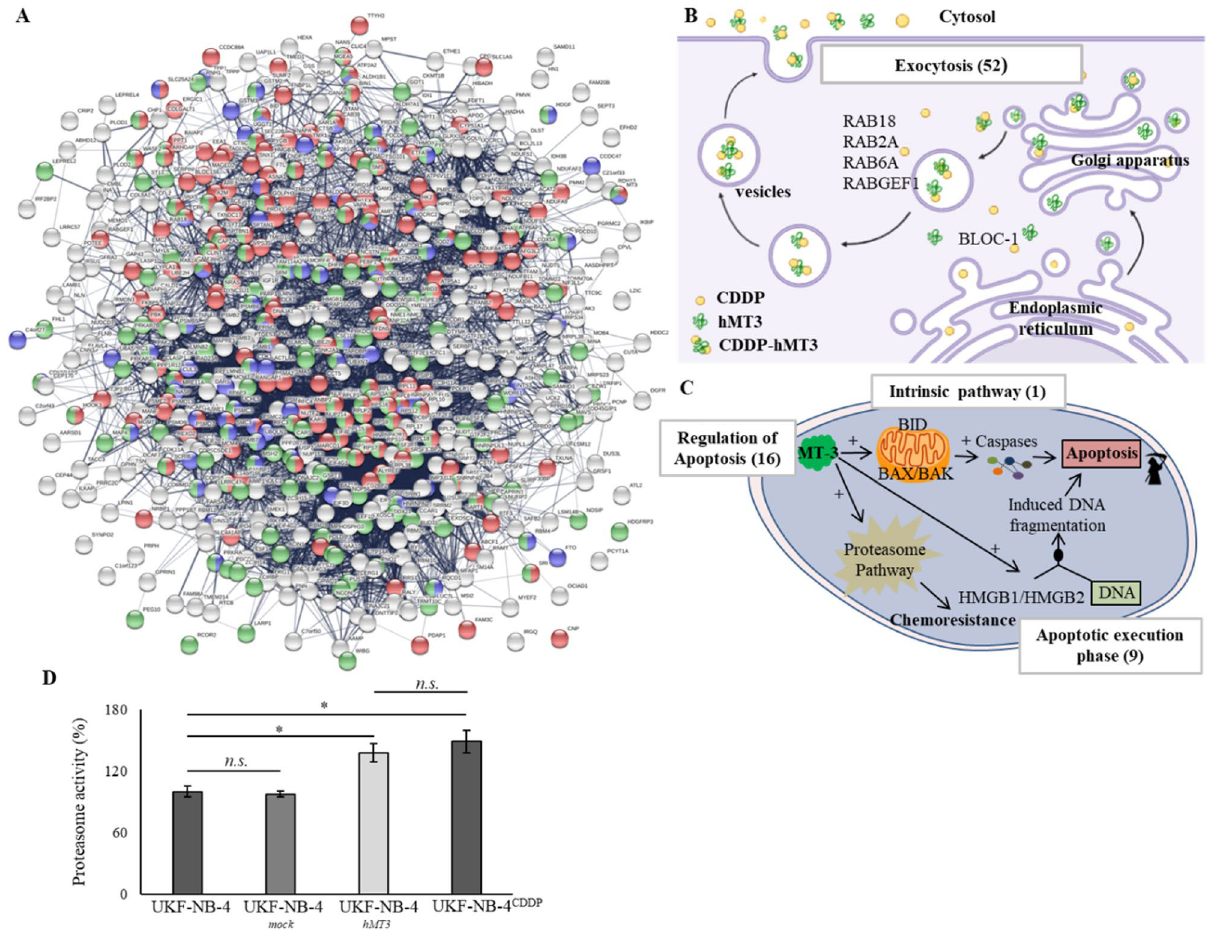
Figure 5. ( A ) STRING interactome network showing the proteins, which were found exclusively expressed and up-regulated in UKF-NB-4 hMT3 cells compared to mock cell line. These are involved in transport (red nodes), cellular response to stress (blue nodes) and negative regulation of biological process (green nodes), respectively. The colour of the line provides evidences of the different interactions among proteins. A red line indicates the presence of fusion evidence; a green line, neighbourhood evidence; a blue line, concurrence evidence; a purple line, experimental evidence; a light blue line, database evidence; a black line, co-expression evidence. Schematic description of ( B ) vesicles-mediated transport and membrane trafficking, and ( C ) apoptotic pathways. The numbers in brackets indicate amount of proteins, which were identified exclusively deregulated due to hMT3 overexpression in UKF-NB-4 cells compared to mock cells. RAB: member RAS oncogene GTPases, BLOC-1: Biogenesis Of Lysosomal Organelles Complex 1, BID: BH3 Interacting Domain Death Agonist, BAX: BCL2 Associated X, BAK: BCL2 Antagonist/Killer, and HMGB1/2: High Mobility Group Box). ( D ) Proteasome activity analysed in parental UKF-NB-4 cells compared to UKF-NB-4 mock , UKF-NB-4 hMT3 and UKF-NB- 4 CDDP cells. The data are results from three ( n = 3) independent experiments. * p < 0.01, n.s., not